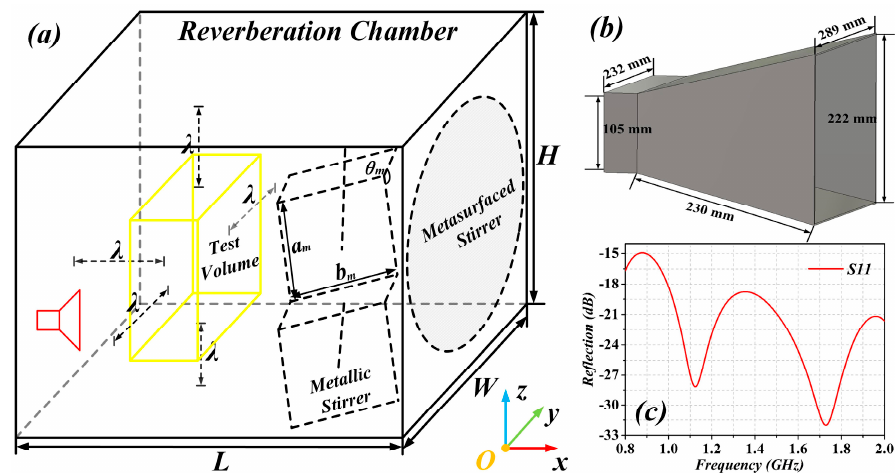
Figure 1. Schematic diagram of the reverberation chamber (RC) with metallic stirrer or with metasurfaced stirrer ( a ), three-dimensional view of the antenna ( b ), and its reflection coefficient ( c ). L = 1.2 m, W = 0.8 m and H = 1.2 m. Dimensions of the metallic stirrer were a m = 0.3 m, b m = 0.4 m, θ m = 120° and the thickness of all the metallic blades was 2 mm. The diameter of the metasurfaced stirrer was 1.2 m, and the considered dielectric layer was 0.031 m thick, with dielectric constant ε r = 2.65 and loss tangent tan δ = 0.001. Sensors 2019 , 19 , x